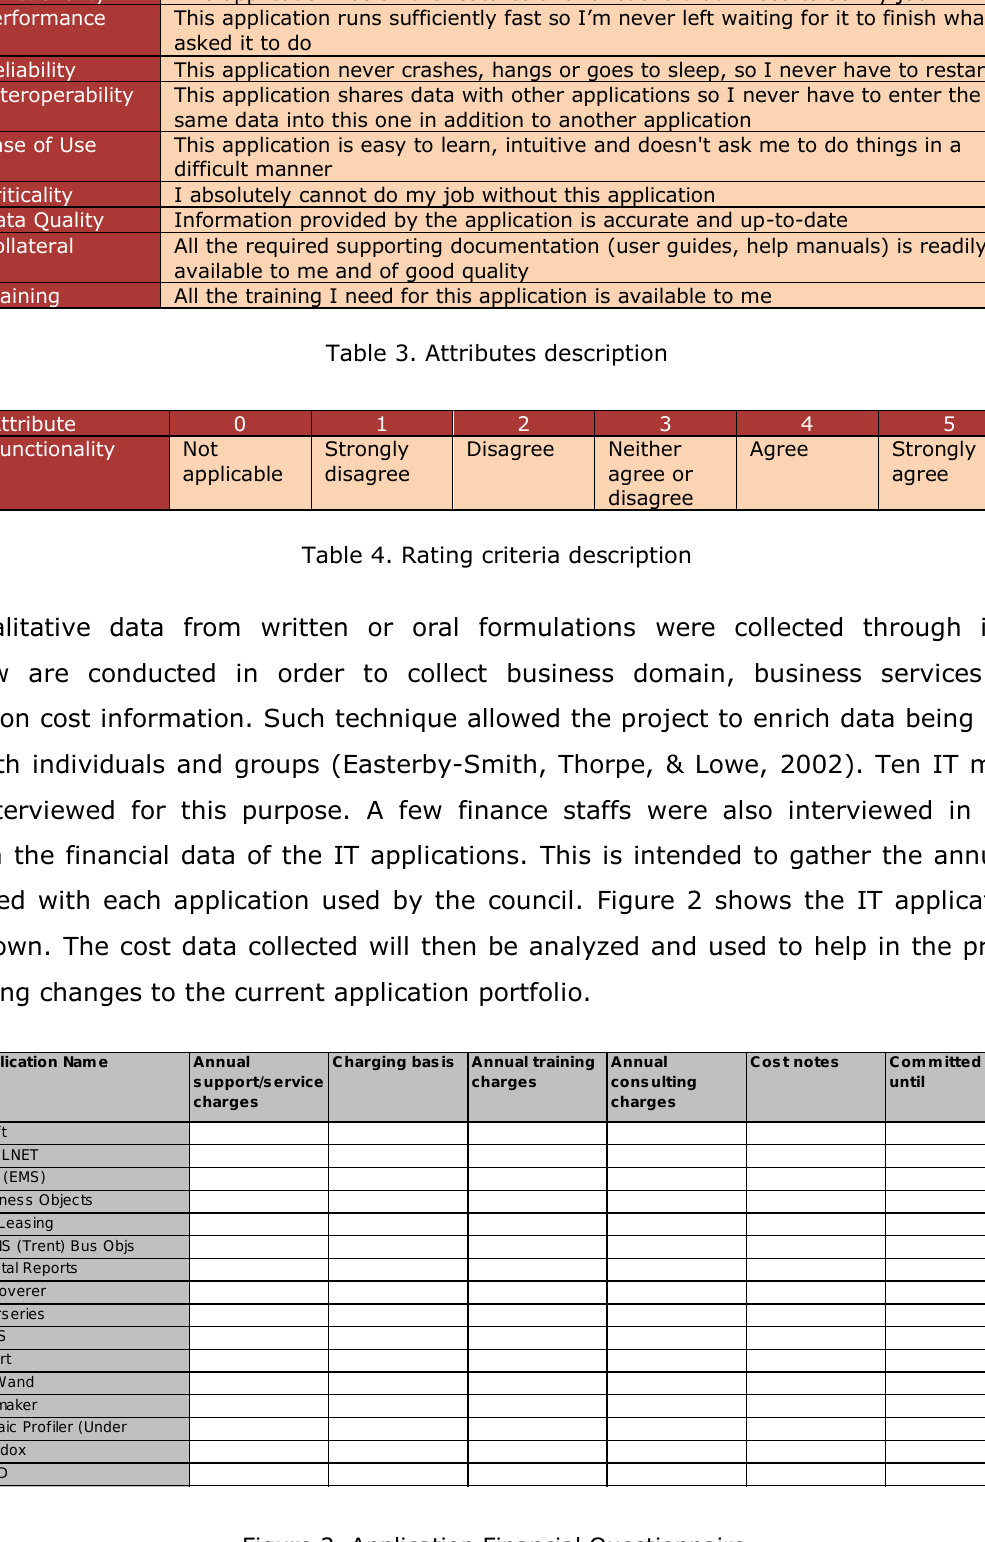
Figure 2. Application Financial